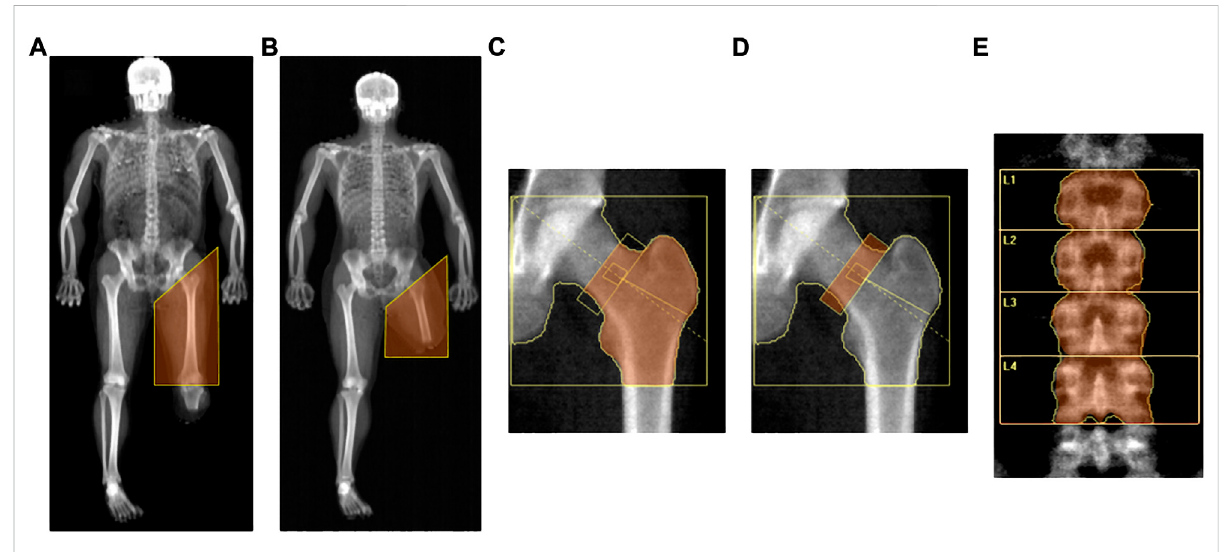
FIGURE 1 DXA-measured regions of interest., Legend. (A) Thigh region of the impaired leg assessed in athletes with AKA (whole-body scan); (B) Thigh regionoftheimpairedlegassessedinathleteswithBKA(whole-bodyscan); (C) Proximalfemurregion(hipscan); (D) Neckofthefemur(hipscan); (E) Lumbar